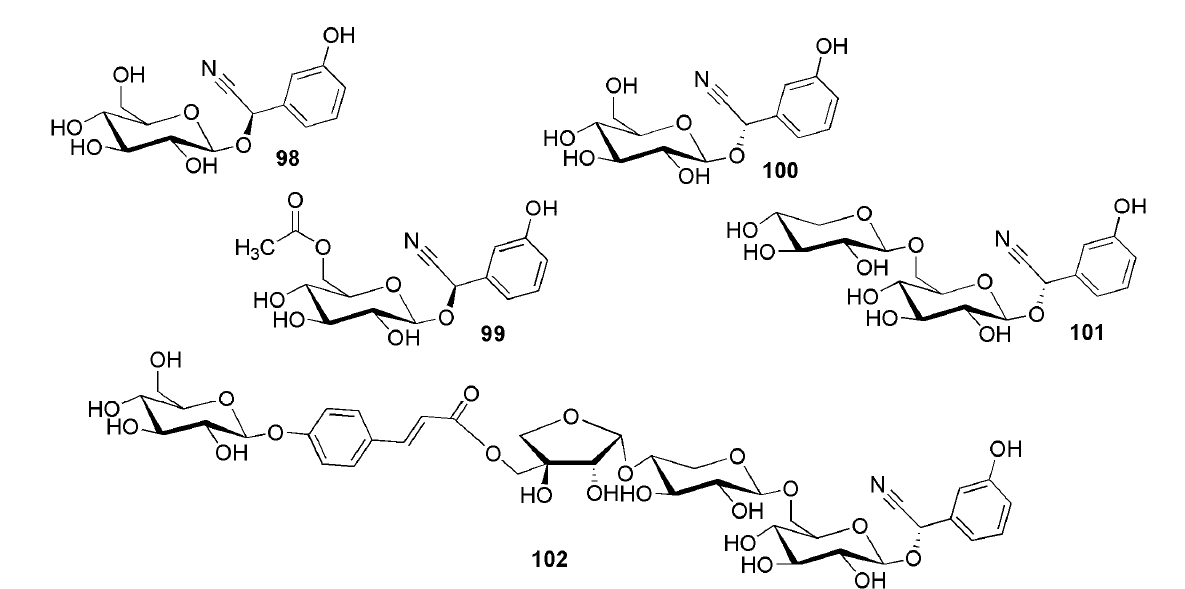
Figure 16. Cyanogenic glycosides group C-6, meta -hydroxyphenyl derivatives: (2 R )-holocalin ( 98 ),